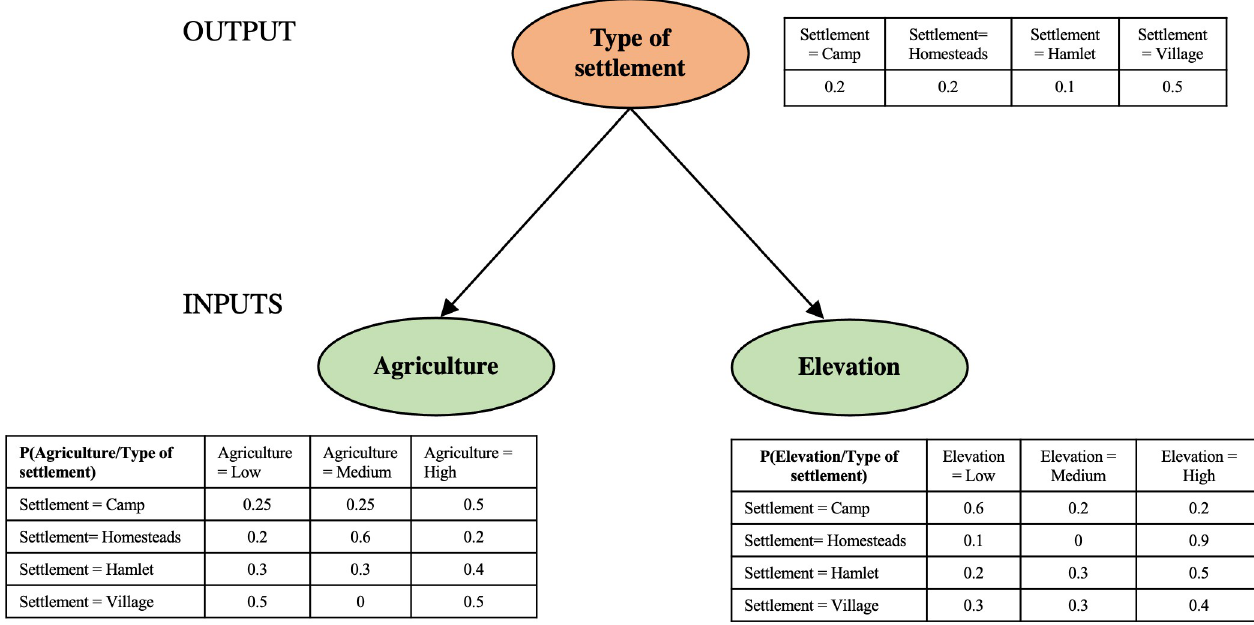
Fig 1. Example of a BN to predict the type of settlement. Type of settlement (output, orange), agriculture and elevation (inputs, green).